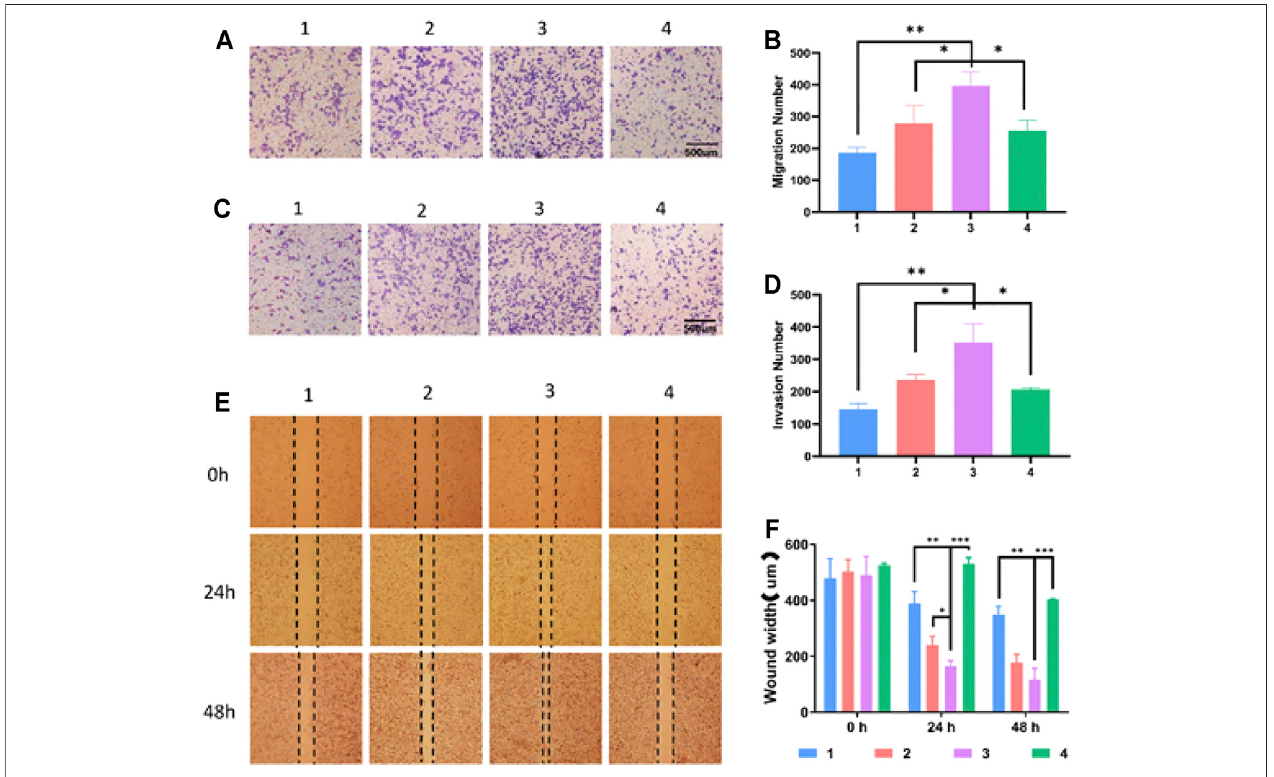
FIGURE 4 | Effect of exosomes of SD on growth and invasion of HCC cells. (A) Cell migration experiment, (B) histogram of migration experiment statistics, (C) cell invasion test, (D) invasion experiment statistics histogram, (E) cell scratch test, (F) scratch experiment statistics histogram. n (cid:2) 3, * p < 0.05, ** p < 0.01, *** p < 0.001, 1) HepG2, 2) HepG2 + HCC exosome, 3) HepG2 + SD-HCC exosome, 4) HepG2 + SD-HCC exosome + CTLA-4 Figure 1A . The SD score (Luo et al., 2017) is an important method for assessing SD by evaluating scores for factors including body odor, mental state, chill and fever, respiration, fur, feces, and appetite. The SD scores assessment showed that the SD group had lower scores than the control group ( p < 0.001) ( Figure 1E ).